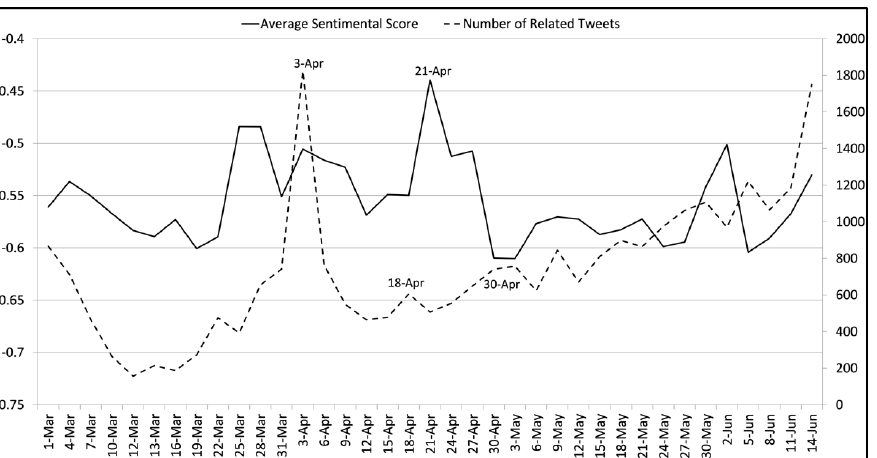
Figure 6. The average sentiment scores and the numbers of tweets related to the mask wearing topic on each collection day from 1 March 2020 to 14 June 2020. The left vertical axis indicates average sentiment scores, while the right vertical axis suggests the number of related tweets collected. The horizontal axis shows the collection dates.